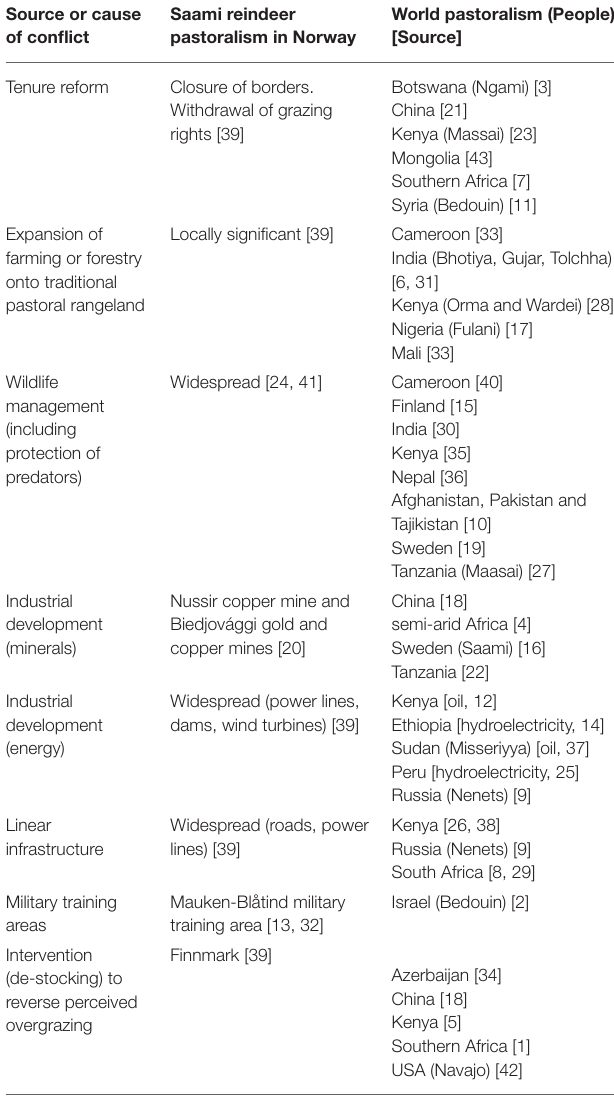
TABLE 3 | Land use conflicts of the kinds outlined in this paper are not unique to Saami reindeer husbandry in Norway: they are a feature of extensive pastoral grazing systems across the